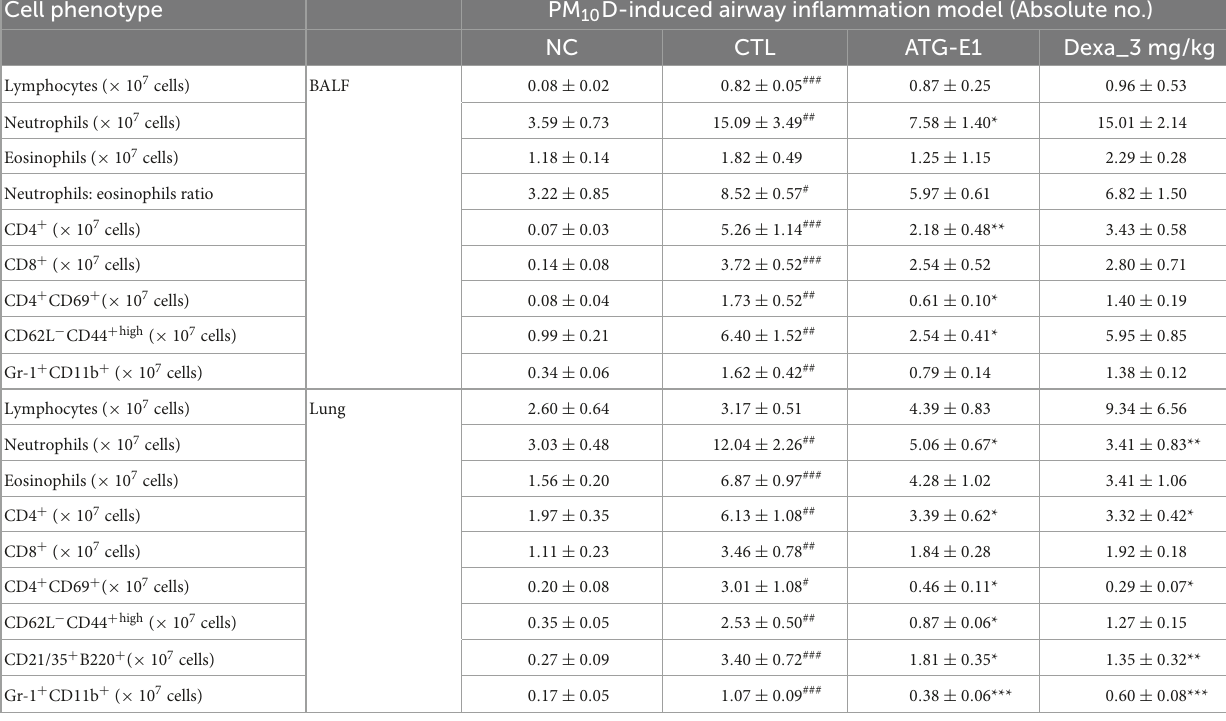
TABLE 3 The effects of L. paracasei ATG-E1 on airway immune cell number in PM 10 D-induced airway inflammation mouse. Cell phenotype PM 10 D-induced airway inflammation model (Absolute no.)